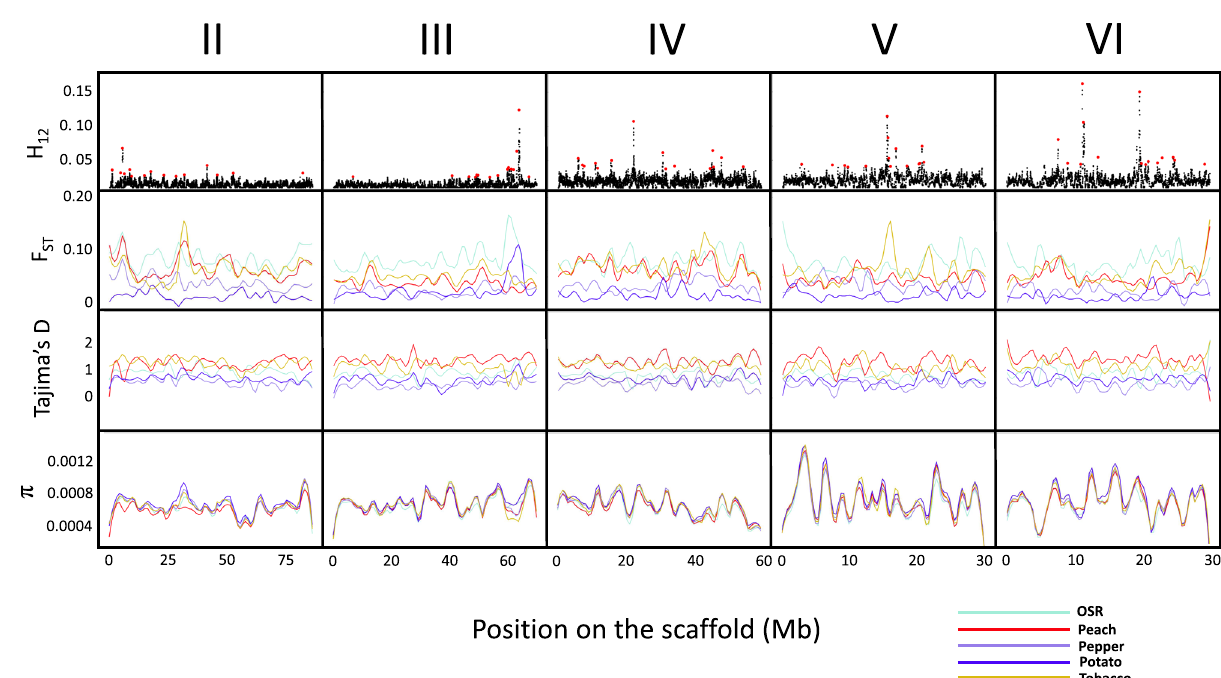
Fig. 4 Genomic divergence and signatures of selection associated with host plant use in M. persicae . Panels from bottom to top display nucleotide diversity ( π ), Tajima ’ s D, F ST, and H12 values across the 5 autosomal chromosomes of M. persicae for the main host plant groups (oilseed rape (OSR), peach, tobacco, pepper and potato), see Supplementary Data 1 for sample sizes. H12 scan: Each data point represents the H12 value calculated based on a 1000 SNP window. Red points highlight the top 15 peaks at each scaffold. Fixation index (F ST ), Tajima ’ s D, and nucleotide diversity ( π ): smoothed lines were estimated based on a 10 kb chromosomal